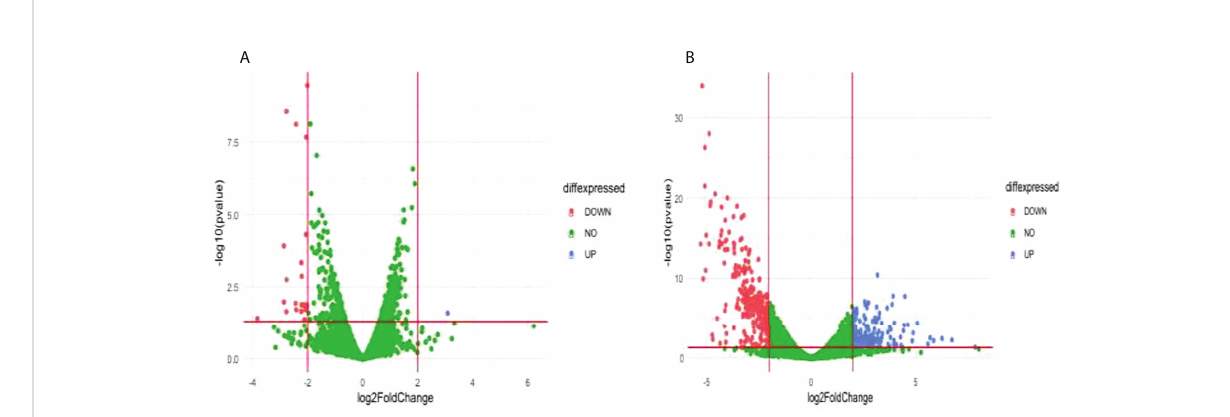
FIGURE 6 Differentially expressed genes (DEG) between compared conditions for the C580R parasite line. Scatter plots indicate the genes differentially expressed (log2 fold expression change > 2 and with a p-value < 0.05). Red vertical lines indicate absolute log2 fold change >2 and red horizontal line indicates p-value < 0.05. (A) Volcano plot for C580R_DMSO treated versus C580R_DHA treated. One gene was upregulated, and 21 genes were downregulated. (B) Volcano plot for C580R_untreated compared with C580R_DHA. 150 genes were upregulated, and 269 genes were downregulated